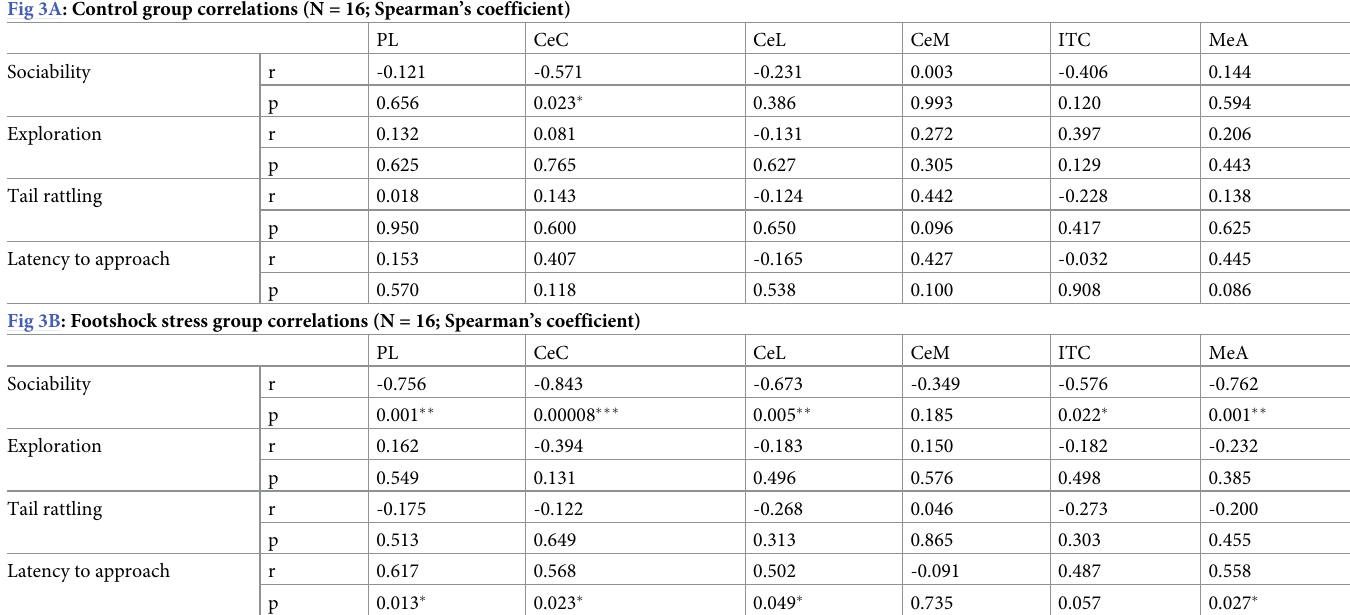
Fig 3A: Control group correlations (N = 16; Spearman’s coefficient)